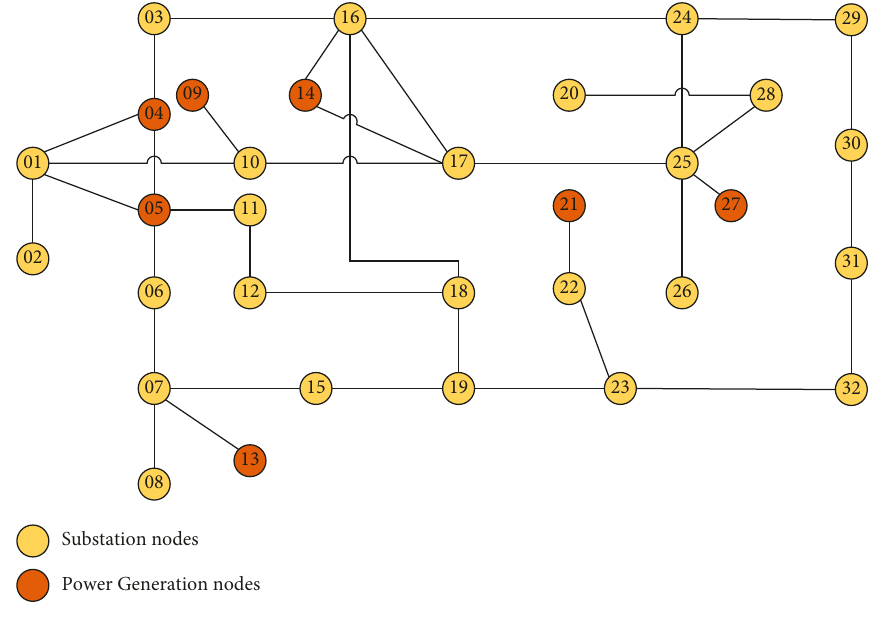
Figure 8: Topology of local power grid. Table 1: Connection between substations and control centers.